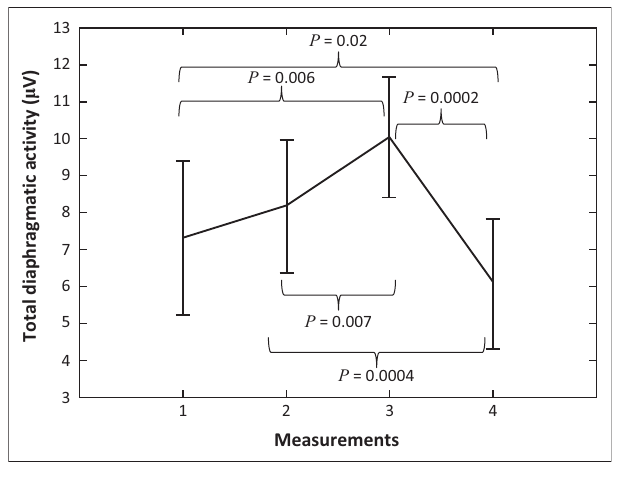
FIGURE 1: Mean change in total diaphragmatic activity at different measurement points (sequence). Vertical bars denote 95 % confidence intervals, overall effect p < 0.0001. Significant changes between measurement points are